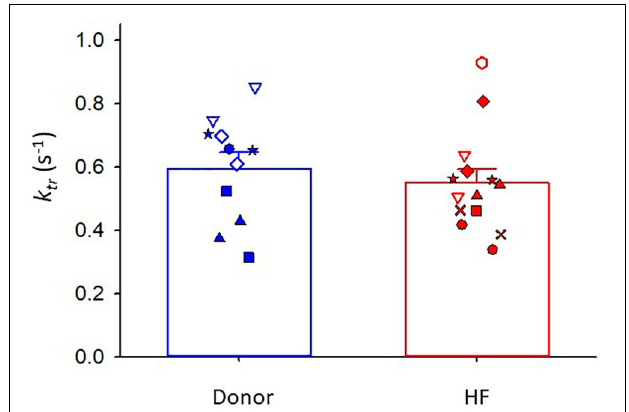
FIGURE 2 | Maximal Ca 2 + -activated tension. Donor group, N = 7 hearts, n = 13 cardiac myocyte preparations. HF group, N = 8 hearts, n = 16 cardiac myocyte preparations. Different symbols indicate data points from each heart sample. Linear mixed model, p = 0.715.